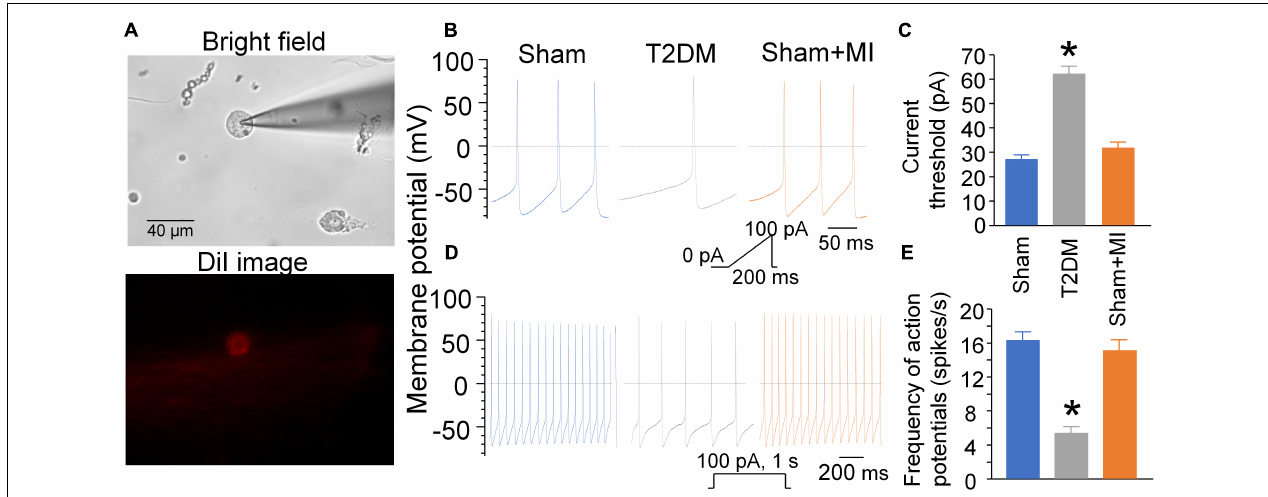
FIGURE 7 | Cell excitability of CPP neurons determined by whole-cell patch-clamp. (A) : DiI-labeled AVG neuron (CPP neuron) with red color in fluorescent light. (B–E) : Current threshold-inducing action potential (AP, B,C ) and frequency of AP (D,E) in CPP neurons (DiI-labeled AVG neurons) from sham, T2DM, and acute MI rats. Current threshold-inducing APs was calculated at the beginning of the first action potential elicited by a ramp current injection of 0–100 pA during 200 ms. The frequency of APs was measured in a 1-s current clamp with a current injection of 100 pA.T2DM significantly reduced the cell excitability of CPP neurons, as evidenced by increased current threshold-inducing APs and reduced frequency of APs in T2DM rats compared to sham rats. MI had no effects on current threshold-inducing APs and frequency of APs. Data are mean ± SEM; n = 10 neurons from 5 rats per group. Statistical significance was determined by one-way ANOVA with post-hoc Bonferroni test. * p < 0.05 vs.